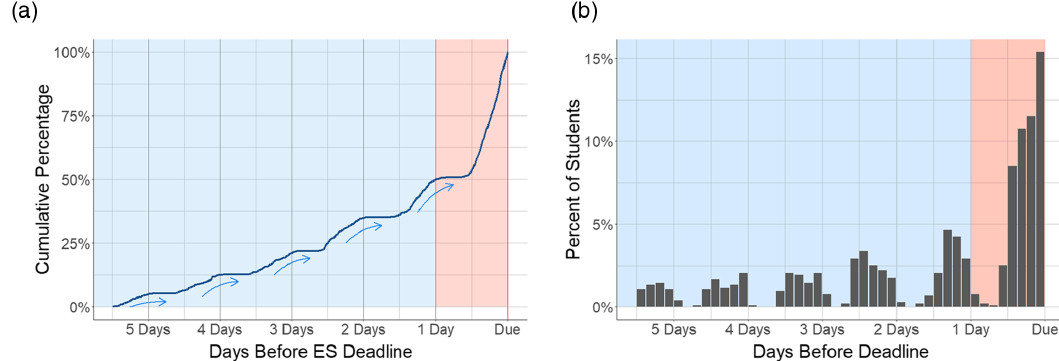
FIG. 1. (a) Cumulative percent of calculus-based physics students completing essential skills assignment #3 before the deadline at 11:59 pm. The blue arrows show the diurnal cycle of student activity. The light blue region highlights the students that completed the essential skills assignment earlier than one day before the deadline. The light red region highlights the students that completed the essential skills assignment within the final 24 h before the deadline. (b) Percent of calculus students completing ES assignment #3 before the deadline binned in 3 h increments. These graphs represent N ¼ 1034 students that completed ES assignment #3.